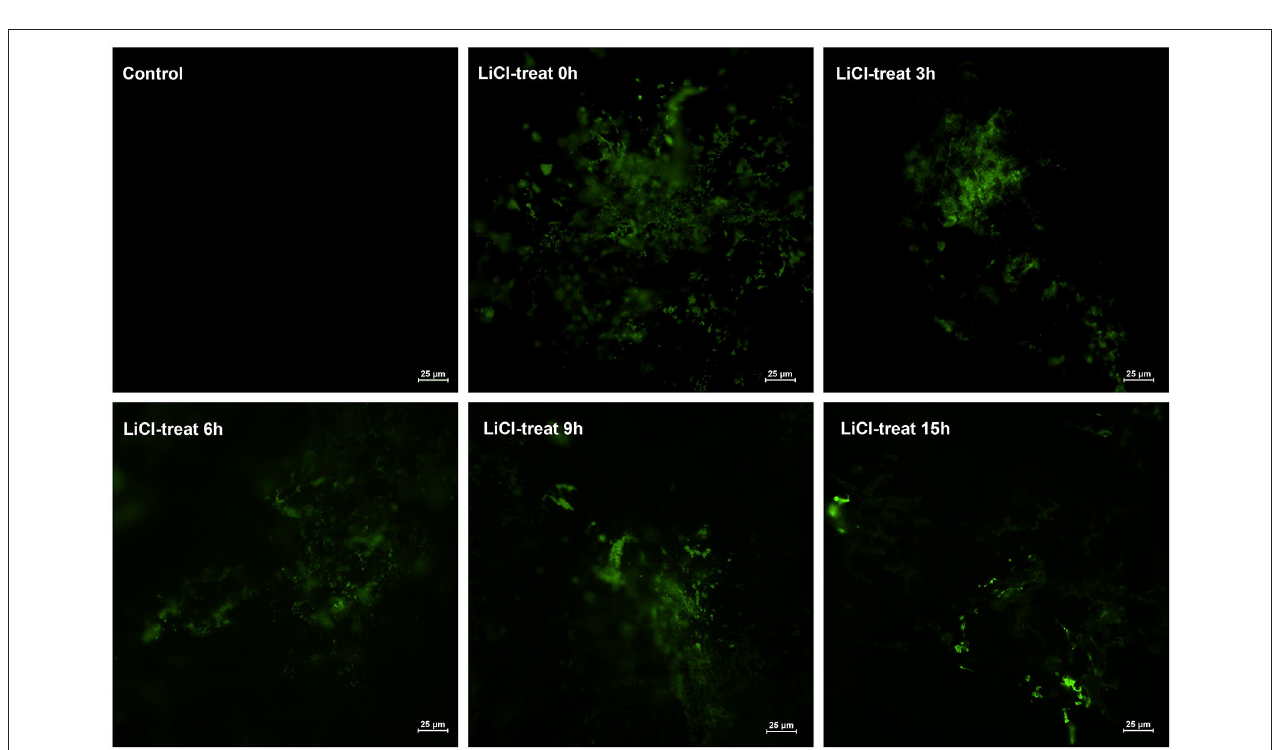
FIGURE 8 | The colonization of L. plantarum HC-2 in the foregut of shrimp was observed under the fluorescence microscope. The normal and LiCl-treated bacteria were labeled with FITC and were added to the basal diet (5 × 10 8 CFU/g feed) to feed shrimps continuously for 2 weeks, and then the foregut was sampled after one day of starvation. The intestinal contents were rinsed with sterile PBS, and the intestinal tract was dissected longitudinally with a sterile scalpel.